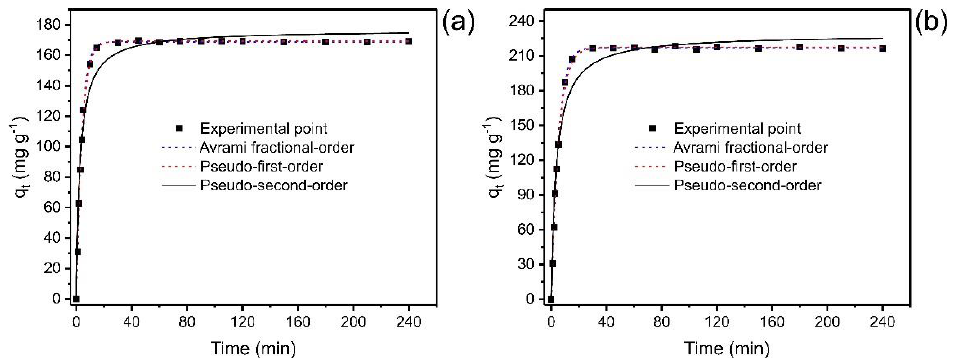
Table 3. Kinetic parameters for adsorption of catechol onto ABC material. Conditions: m 30 mg; pH 7.0; temperature 25 °C.